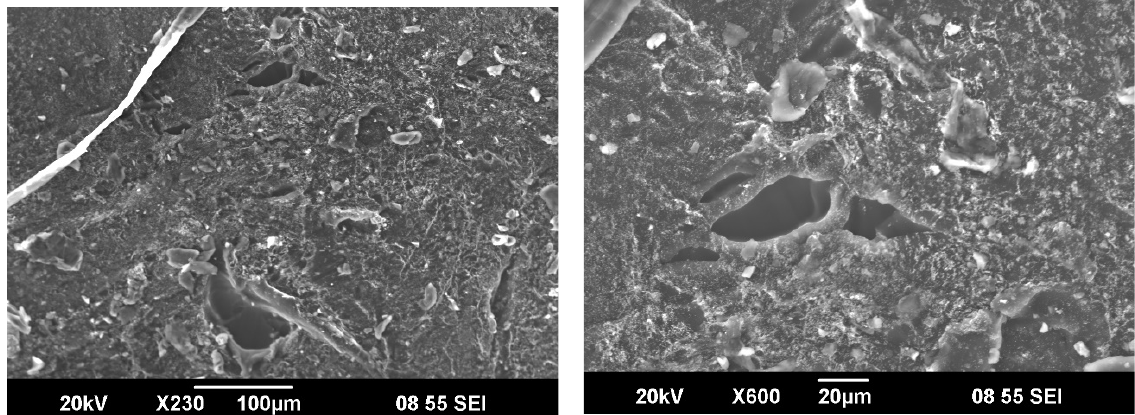
Figure 6. SEM Micrographs of poly(DMA – co – AAc) hydrogel (M3).